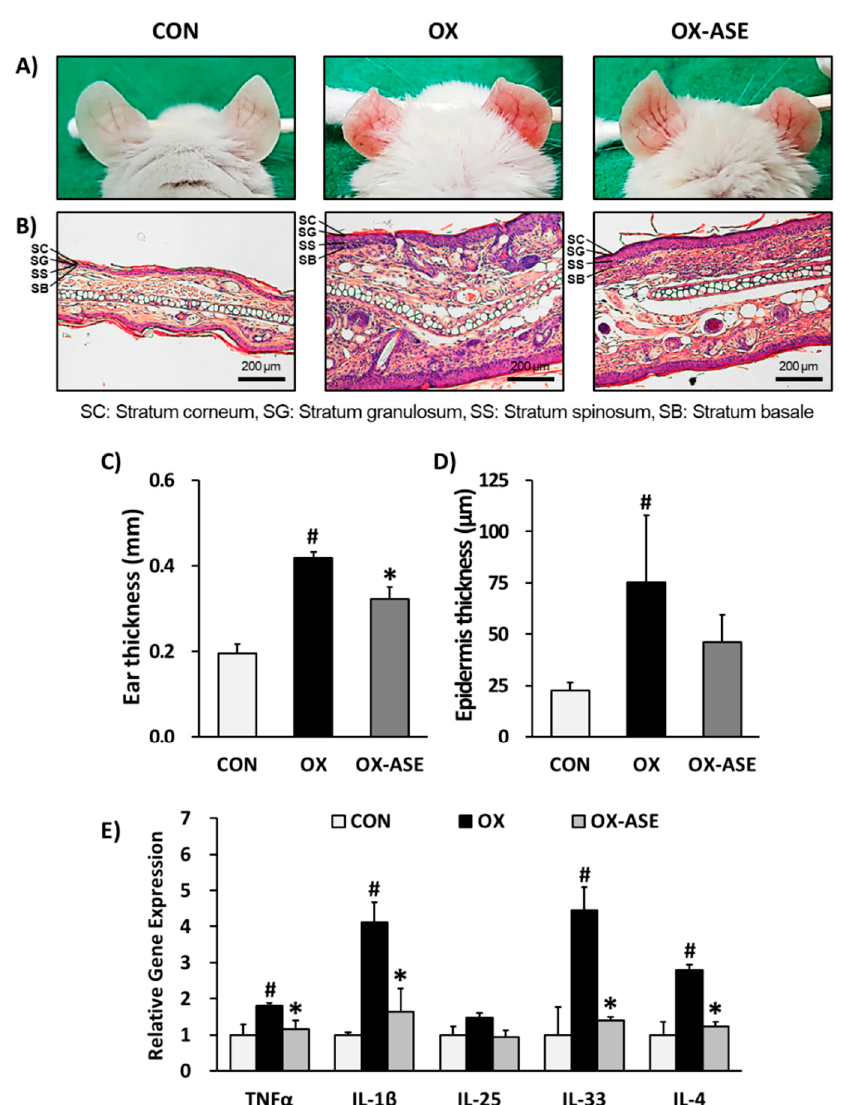
Figure 1. Acorn shell extract (ASE) improved atopic dermatitis (AD) in oxazolone-induced Balb/c mice. Clinical features of mouse ears ( A ). Hematoxylin and eosin (H&E) staining (200× magnification, B ). Ear thickness ( C ). Epidermal thickness of ear ( D ). Relative gene expression of cytokines (TNF α , IL-1 β , IL-25, IL-33, IL-4) ( E ). Data are presented as the mean ± standard deviation (SD), and were